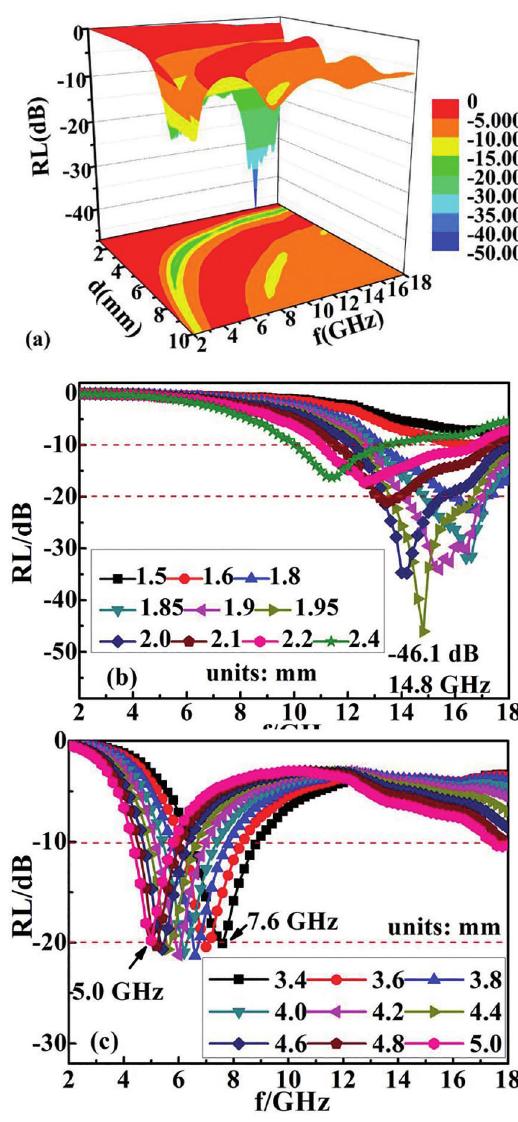
Figure 4: RL of FeNi/SnO nanocapsules-paraffin composites as a function of thickness and frequency: (a) three dimensional representation with the thickness of 1.0-10.0 mm and (b) two dimensional representation with the thickness of 1.5-2.4 mm and (c) two dimensional representation with the thickness of 3.4-5.0